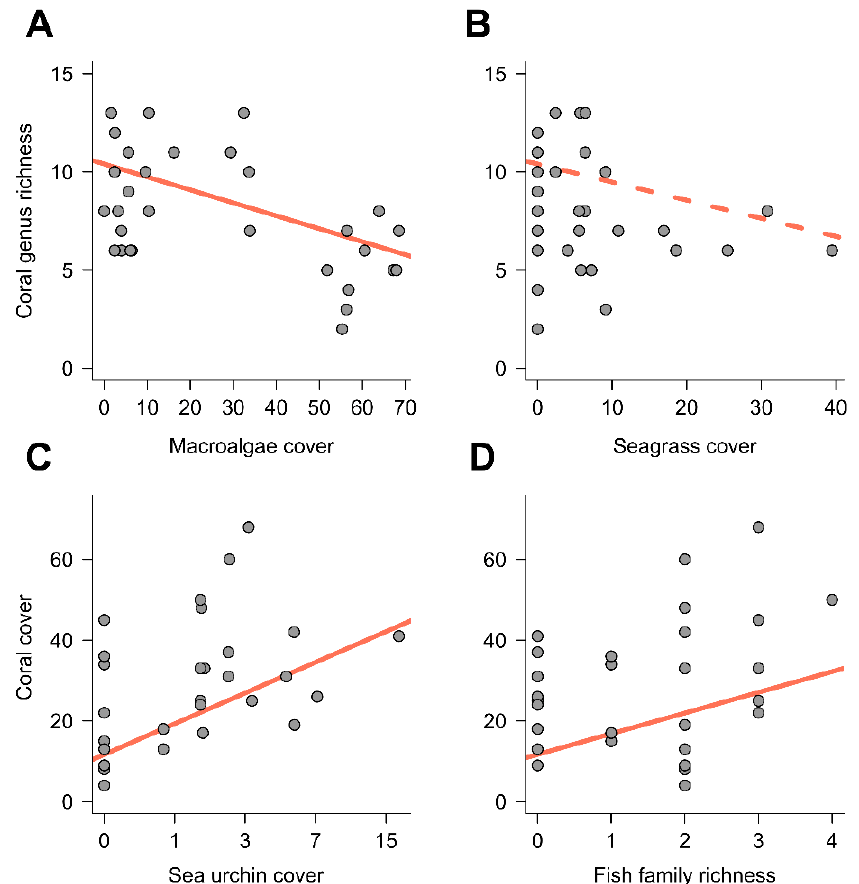
Figure 2. Relationship of different substrate variables to coral genus richness and coral cover at the